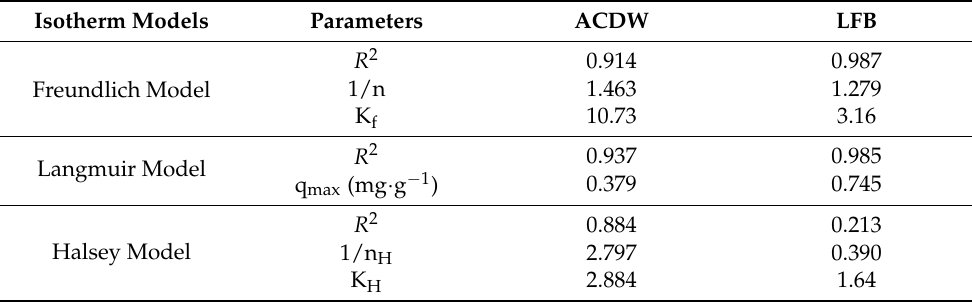
Figure 10. Halsey model plot for the sorption of ammonia using whole biomass (ACDW) and li ‐ pid ‐ free biomass (LFB) of Arthrospira platensis. Table 2. Isotherm factor of ammonium ion adsorptions (ACDW and LFB). Isotherm